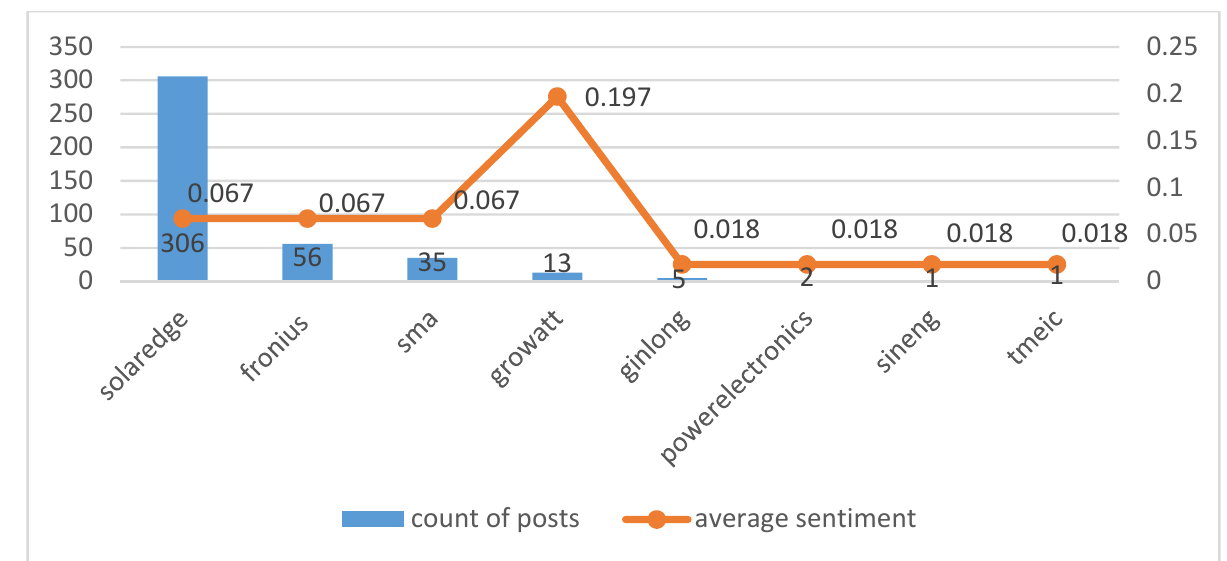
Figure 4. The number of posts and the average sentiments expressed in the posts.